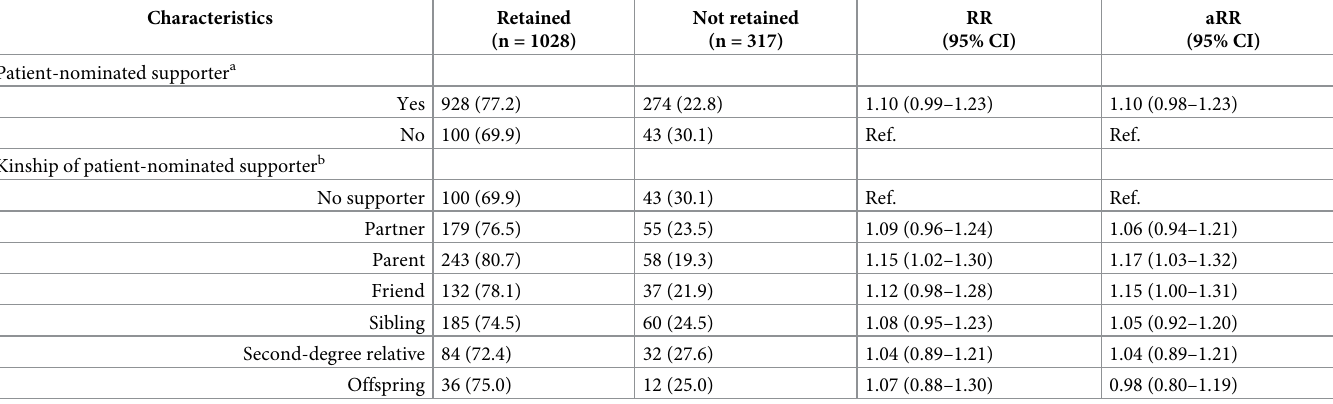
Table 3. Associations between having patient-nominated supporters and being retained in care after one year among people living with HIV, 2011–2014. Characteristics